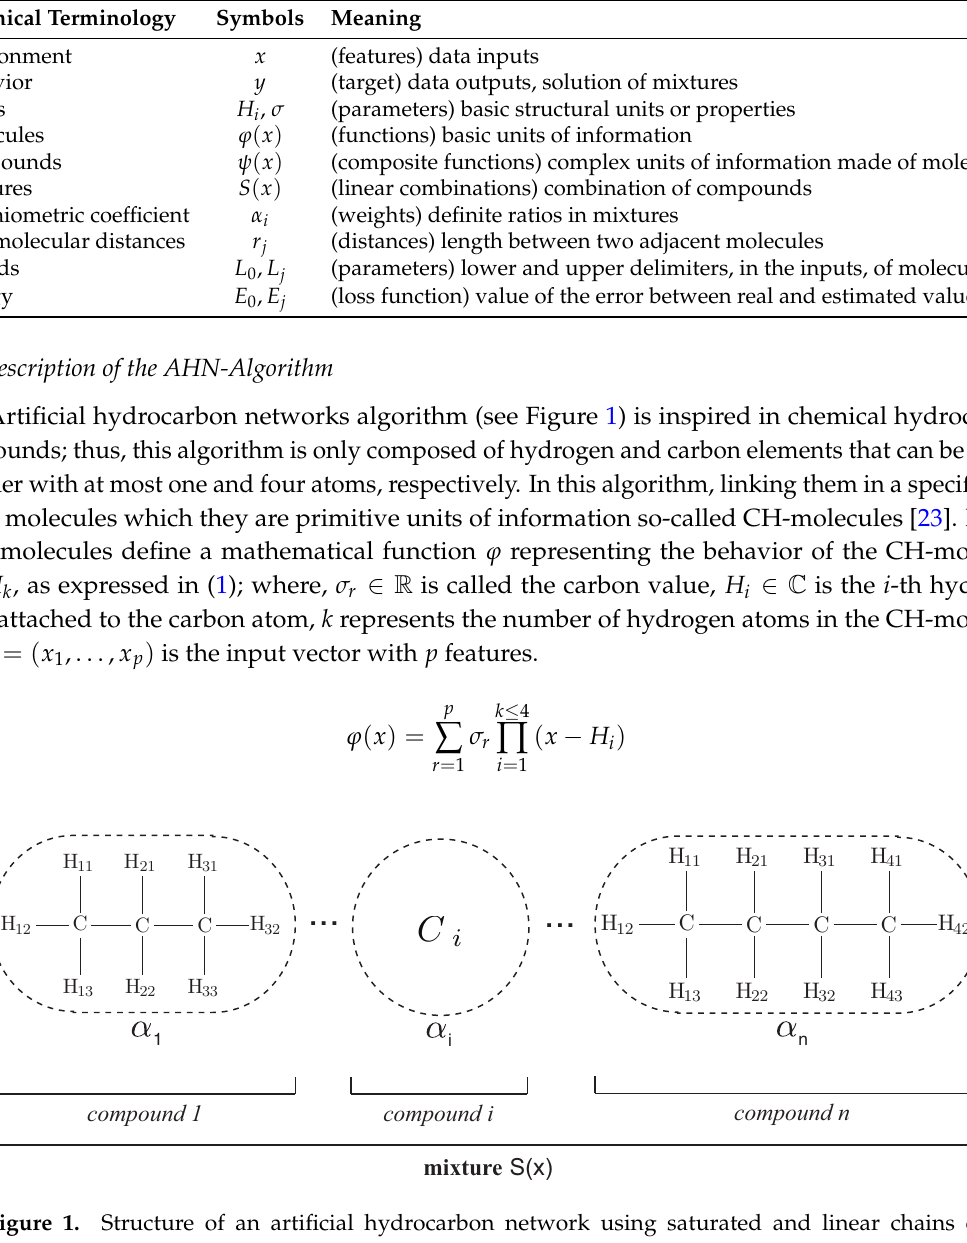
Figure 1. Structure of an artificial hydrocarbon network using saturated and linear chains of molecules [26]. Throughout this work, the topology of the proposed classifier considers